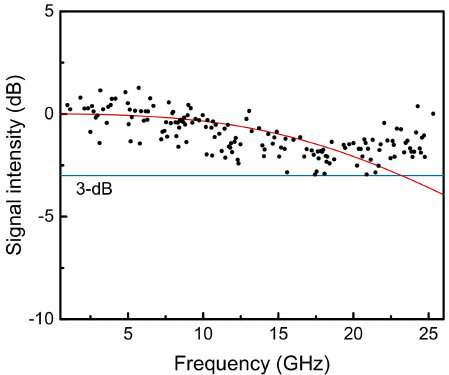
Figure 6. Frequency response of the quantum cascade (QC) detector observed in heterodyne beat measurement. The black dots are experimental data obtained by using the max-hold trace mode of the spectrum analyzer. The red curve is a theoretical prediction of the frequency response using the mea- sured capacitance of 0.19 pF, the calculated inductance of 0.21 nH, and the input impedance of 50 Ω . Figure 7 plots the heterodyne spectroscopy of the N 2 O absorption lines. Figure 7a shows the entire measurement range, while Figure 7b–d were enlarged spectra. Each absorption signal was extracted by using the background obtained with the empty multi- pass cell. The black dots and red lines correspond to the experimental and calculated results, respectively (SpectraPlot [23,24]), where both were normalized by maximum values around 2220.4 cm − 1 . The experimental absorption strengths, peak positions, and spectral widths in the three spectra agree well with the calculations in the spectral range of ~0.8 cm − 1 .